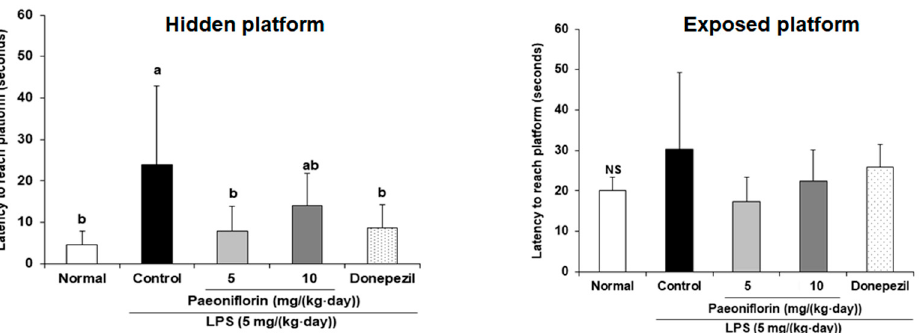
Figure 4. Effect of paeoniflorin on the latency to reach the hidden platform and exposed platform in the Morris water maze test. Data represent the mean ± SD. a,b Means with different letters are significantly different ( p < 0.05) by a Duncan’s multiple range test. NS indicates no significant differences among experimental groups. Normal group = 0.9% NaCl i.p. ; Control group = LPS (5 mg/kg/day) i.p. + 0.9% NaCl i.p. ; Paeoniflorin 5 group = LPS (5 mg/kg/day) i.p. + paeoniflorin (5 mg/kg/day) i.p. ; Paeoniflorin 10 group = LPS (5 mg/kg/day) i.p. + paeoniflorin (10 mg/kg/day) i.p. ; Donepezil group = LPS (5 mg/kg/day) i.p. + donepezil (5 mg/kg/day) i.p.